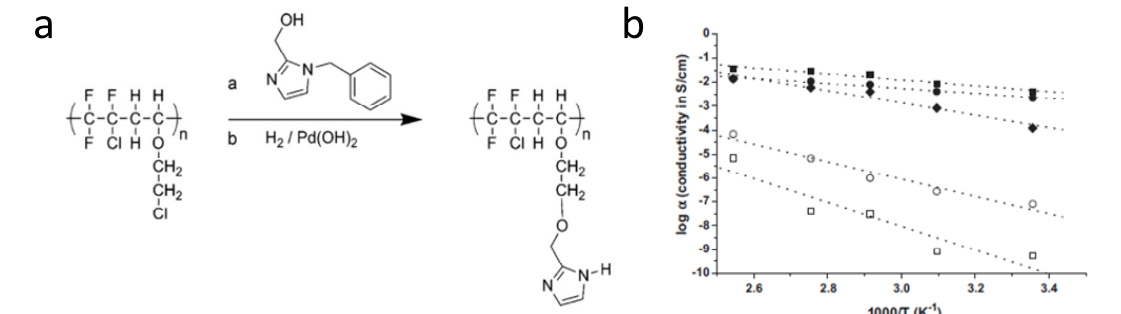
Figure 5. ( a ) Preparation of fluorinated copolymer bearing pendant imidazole groups and ( b ) logarithm of proton conductivity vs. reciprocal temperature for the blend membranes consisting of SPEEK and the copolymer-containing pendant imidazole groups. (Reprinted with permission from [44]. Copyright 2011 Elsevier).